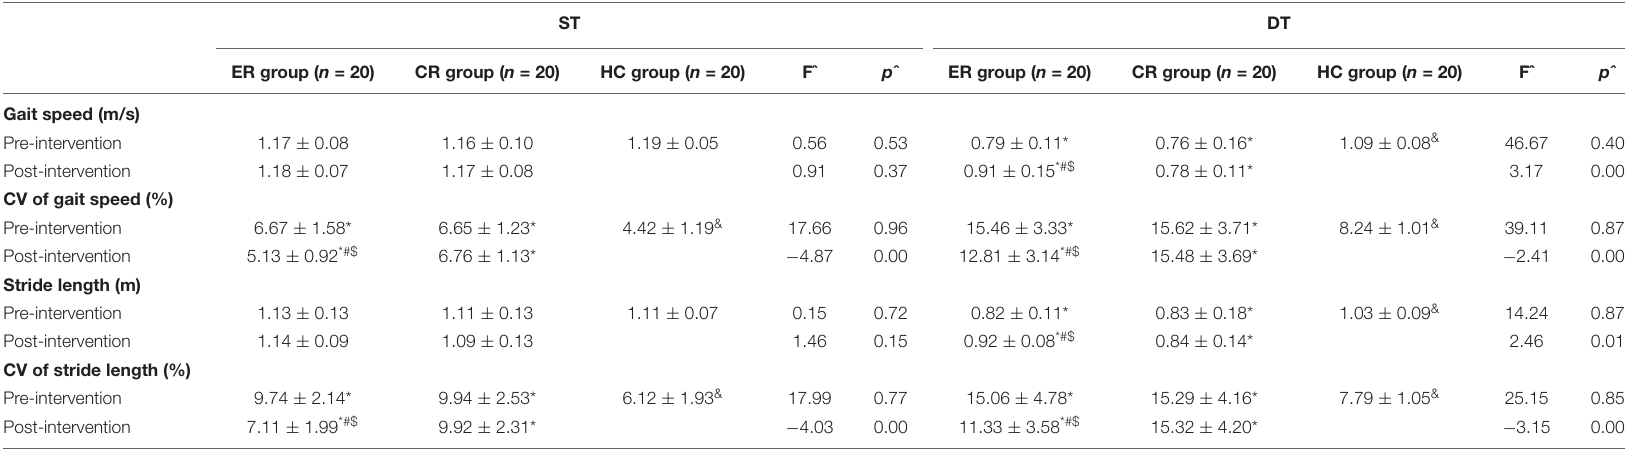
TABLE 2 | Gait characteristics for all participants pre- and post-intervention. ST